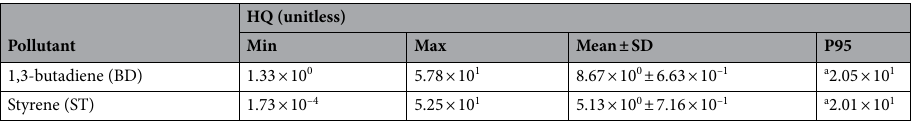
Table 4. Non-carcinogenic risk (HQ) values and probability distribution of BD and ST in the inhalation exposure to the employees in carpet industry. a The non-carcinogenic risk value exceeds the acceptable level (HQ > 1); P95—95th